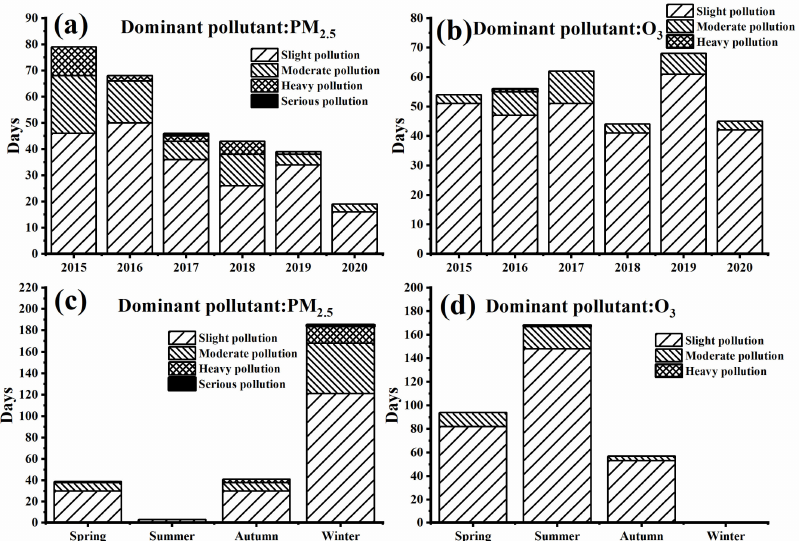
Figure 2. ( a ) Annual variations in polluted days for the dominant pollutant PM 2.5 in 2015–2020; ( b ) Annual variations in polluted days for the dominant pollutant O 3 in 2015–2020; ( c ) Seasonal variations in polluted days for the dominant pollutant PM 2.5 in 2015–2020; ( d ) Seasonal variations in polluted days for the dominant pollutant O 3 in 2015–2020. From Figure 2a, it can be seen that the number of days with PM 2.5 as the dominant pollutant decreased yearly, with 89 in 2015 and only 18 in 2020, with an annual rate of decrease of 16.0%. Meanwhile, the number of slightly polluted, moderately polluted, and heavily polluted days also showed a significant decline.